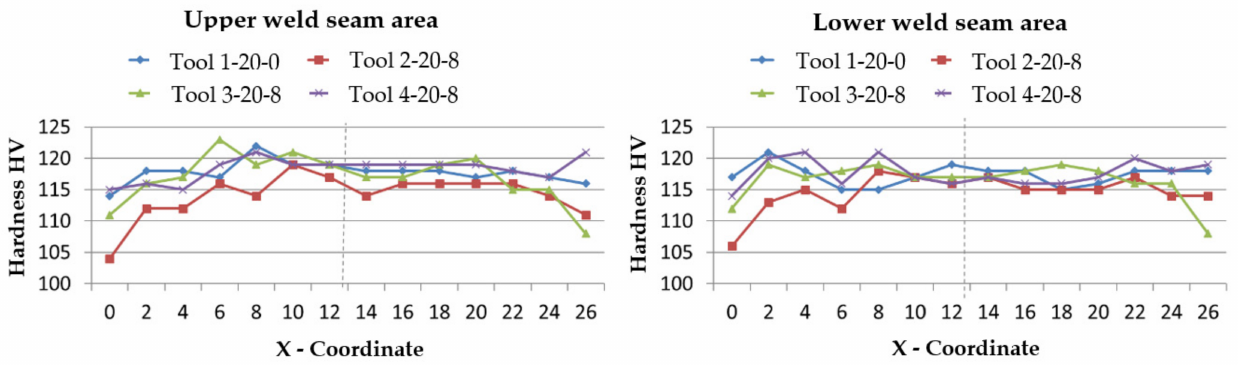
Figure 24. Hardness profiles over the welding seam for welds with 0.9 mm joint gap for material EN AW 7020